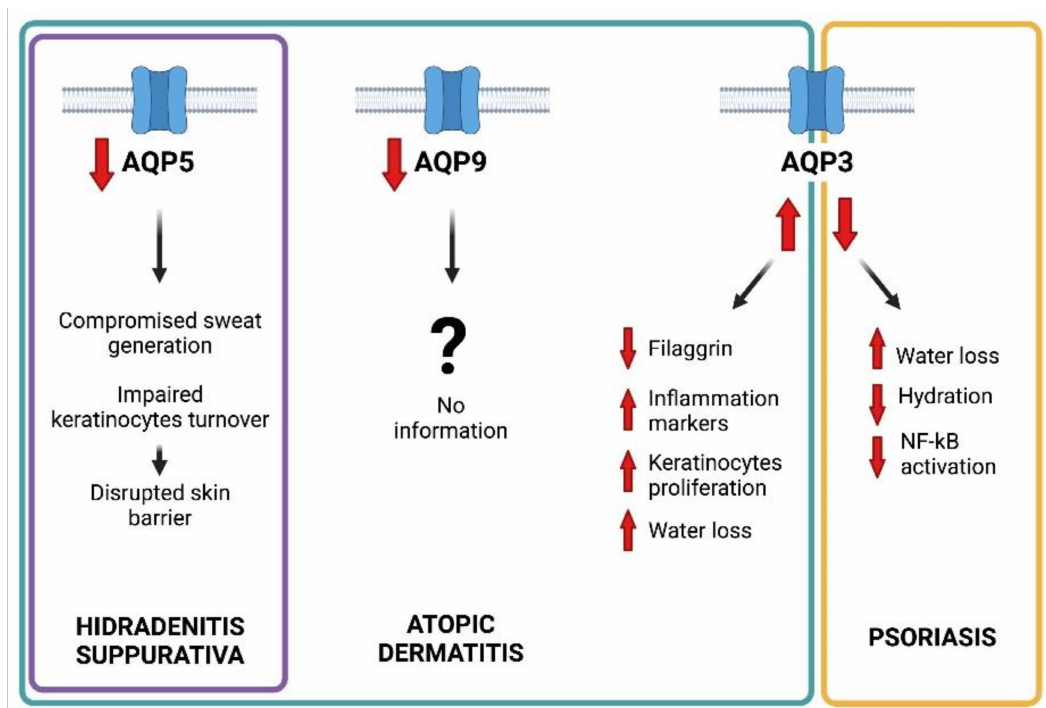
Figure 3. Graphical representation of the main pathophyioslogical roles suggested for AQP5, AQP9, and AQP3 in hidradenitis suppurativa, atopic dermatitis, and psoriasis,